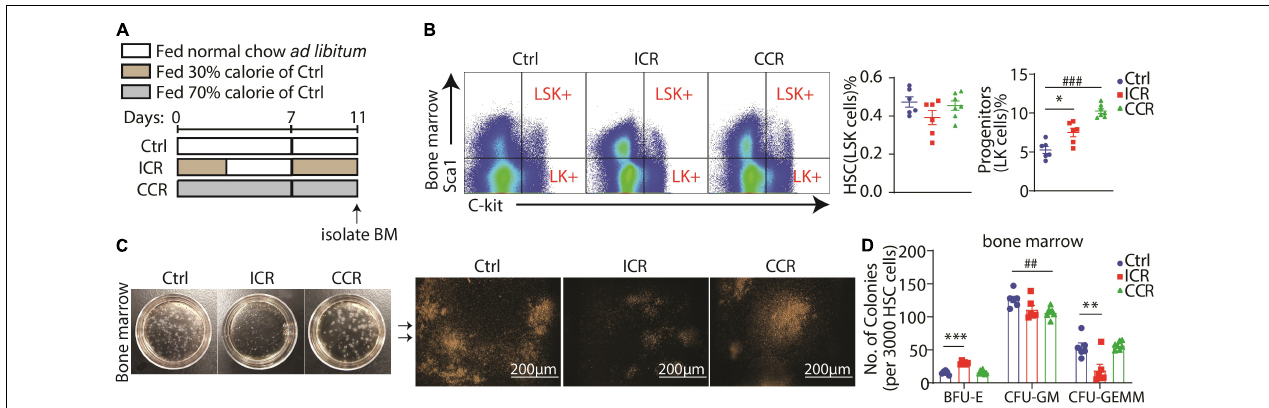
FIGURE 5 | A short-term CR affects hematopoiesis in bone marrow from progenitors. (A) Design of the experiment. Seven-week-old male C57BL/6 mice were divided into three groups ( n = 6 for control group, n = 6 for intermittent CR group and n = 7 for continuous CR group). (B) Proportion of LSK + cells and LK + cells in bone marrow. Quantitation of the FACS results is shown in the right panel. (C) Representative images of colonies formed from LSK + cells of the bone marrow. The amplified images are shown in the right panel. Scale bar 200 µ m. (D) Colony counts of BFU-E, CFU-GM, and CFU-GEMM derived from LSK + cells in the bone marrow. All the data are presented as mean ± S.E.M. ∗ P < 0.05, ∗∗ P < 0.01, ∗∗∗ P < 0.001 for difference between control and intermittent CR groups. ## P < 0.01, ### P < 0.001 for difference between control and continuous CR groups.